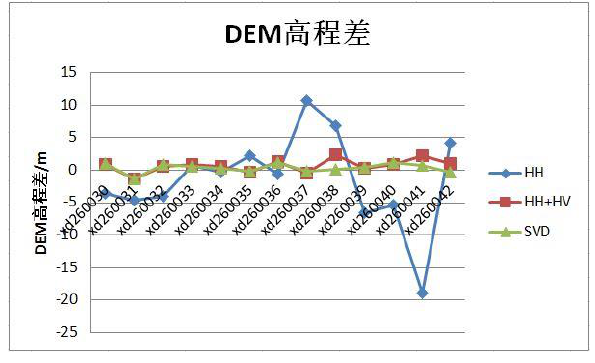
Figure 4. DEM elevation difference